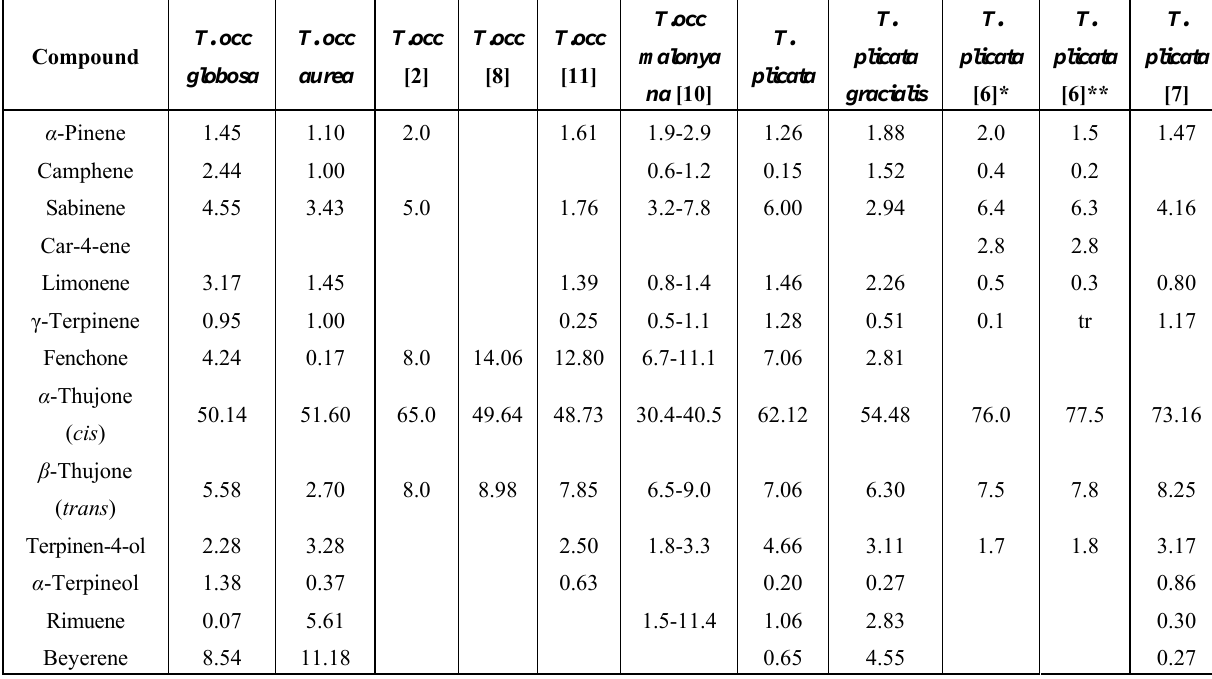
Table 2. Quantities (%) of abundant components of different origin Thuja leaf essential